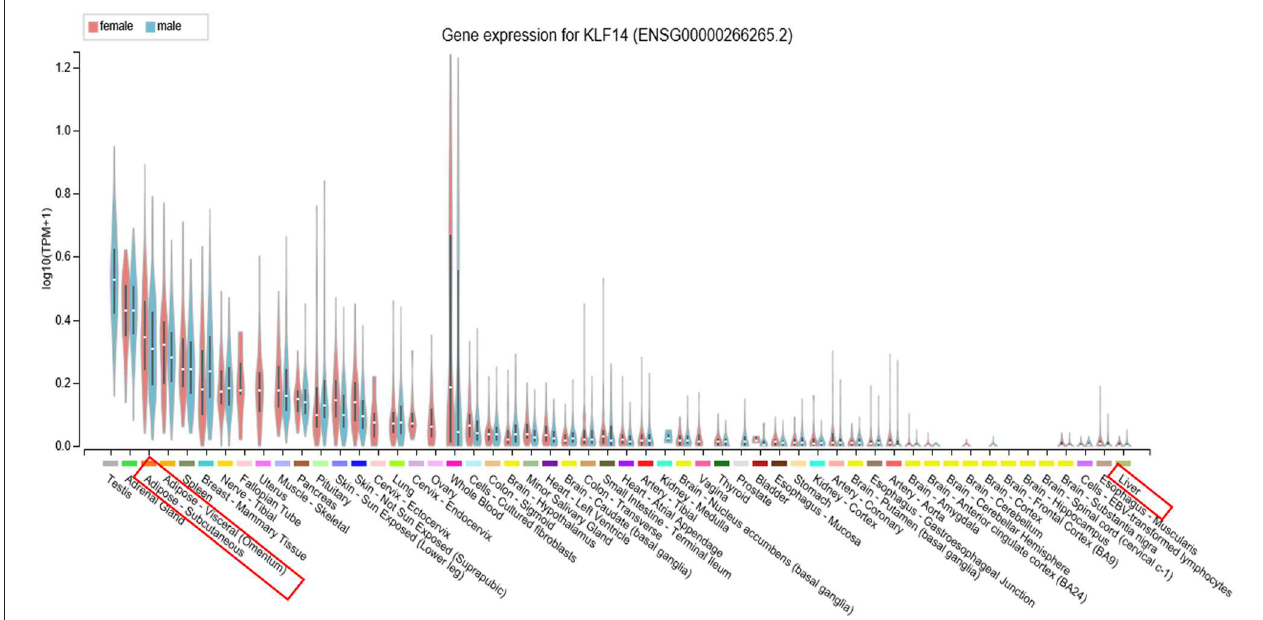
FIGURE 1 | KLF14 expression in human tissues. Expression of KLF14 in 54 tissues or cell types from several hundred male and female donors was measured using RNA sequencing as part of the Genotype-Tissue Expression project. The results show widespread expression of KLF14 in various tissues, variation in the abundance of KLF14 in each human donor, and generally higher expression level in females compared to males. Image obtained from the GTEx Portal